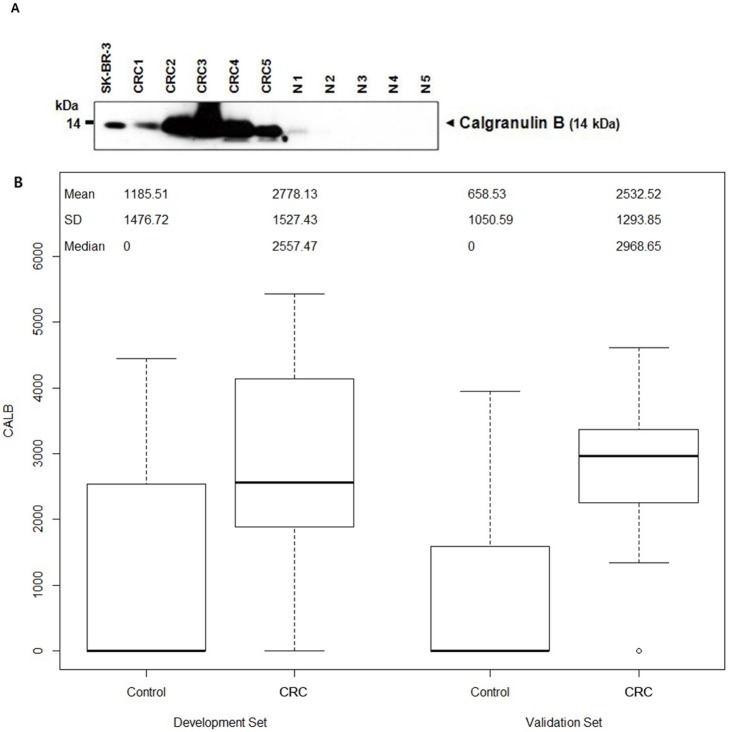
Calgranulin B level in stool of cancer and control patients (A) Western blotting showing various levels of calgranulin B in stool samples from CRC patients (CRC1–CRC5) and healthy controls (N1–N5).The human breast cancer cell line SK-BR-3 was used as a positive control for calgranulin B. (B) CALB concentrations in case (colorectal cancer patients) and control patients are shown separately for the development and validation sets.